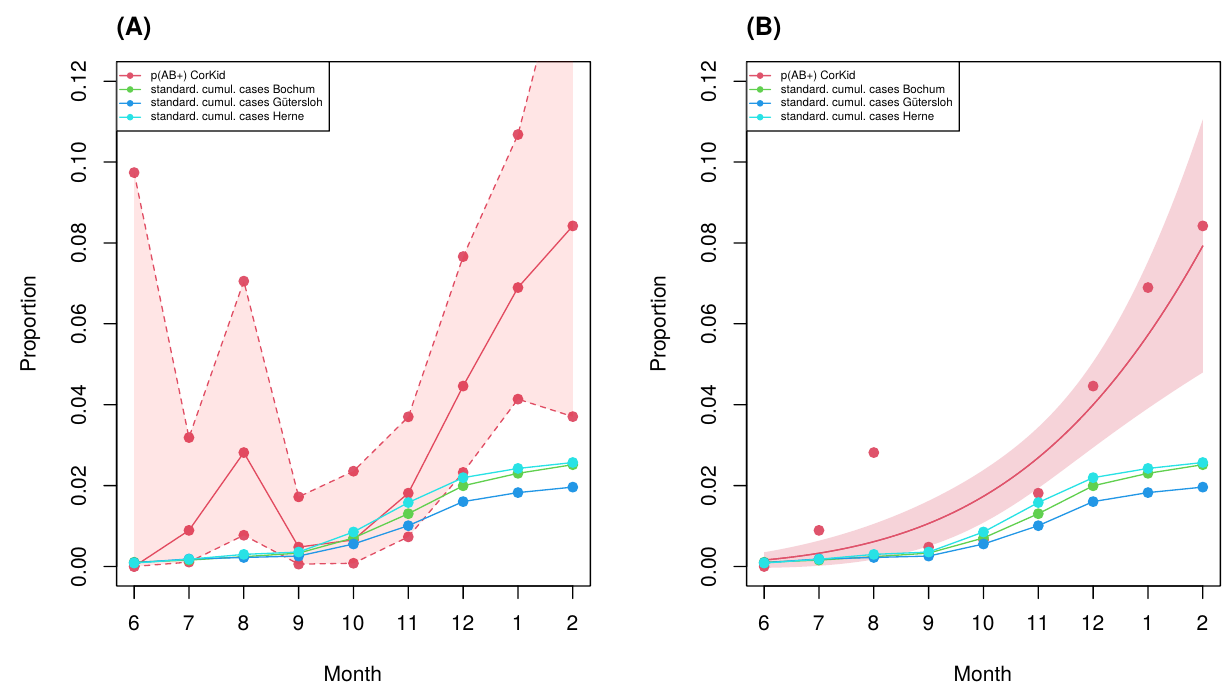
Figure 3. Time series of observed seroprevalence (proportion of seropositive patients) from the Corkid study and official RKI- registered age-standardized per capita cumulative cases for the three counties relevant for the study. ( A ) Plain observations with 95% confidence interval. ( B ) Model prediction from a logistic curve fitted to the observed